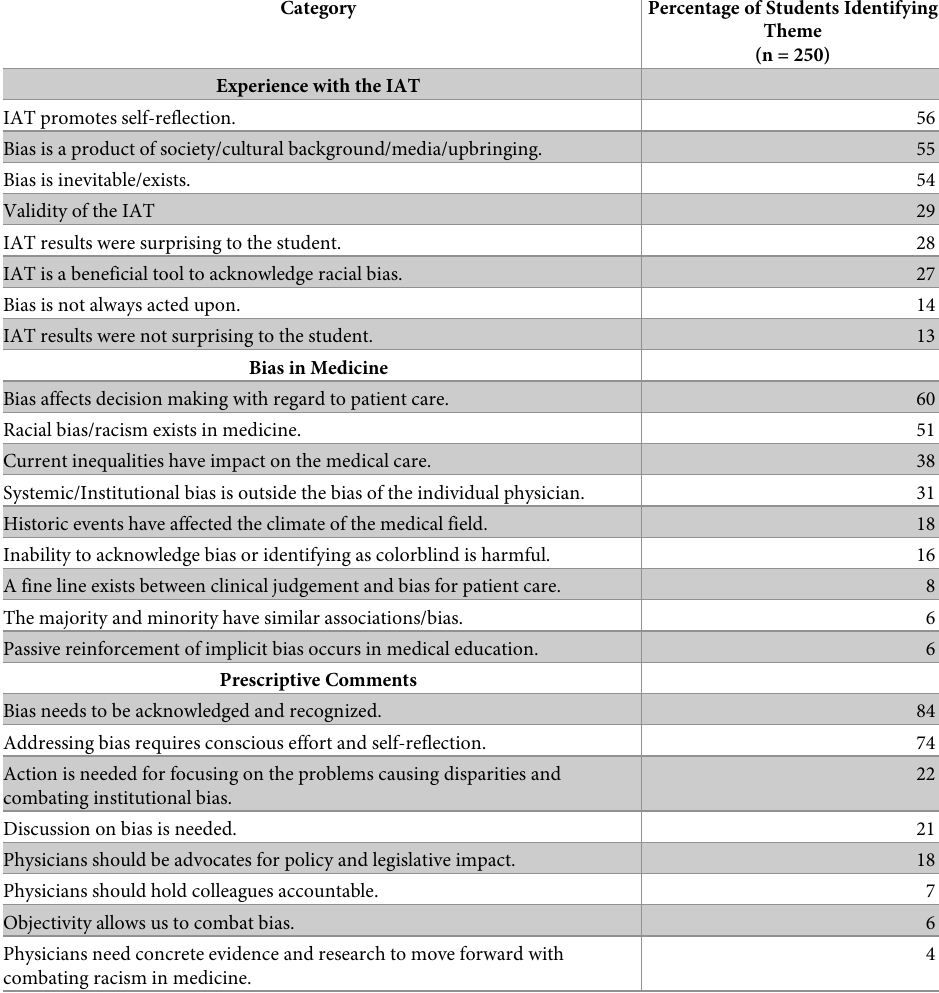
Table 1. Percentage of student essay content mapping to three categories and their themes. Category Percentage of Students Identifying Experience with the IAT